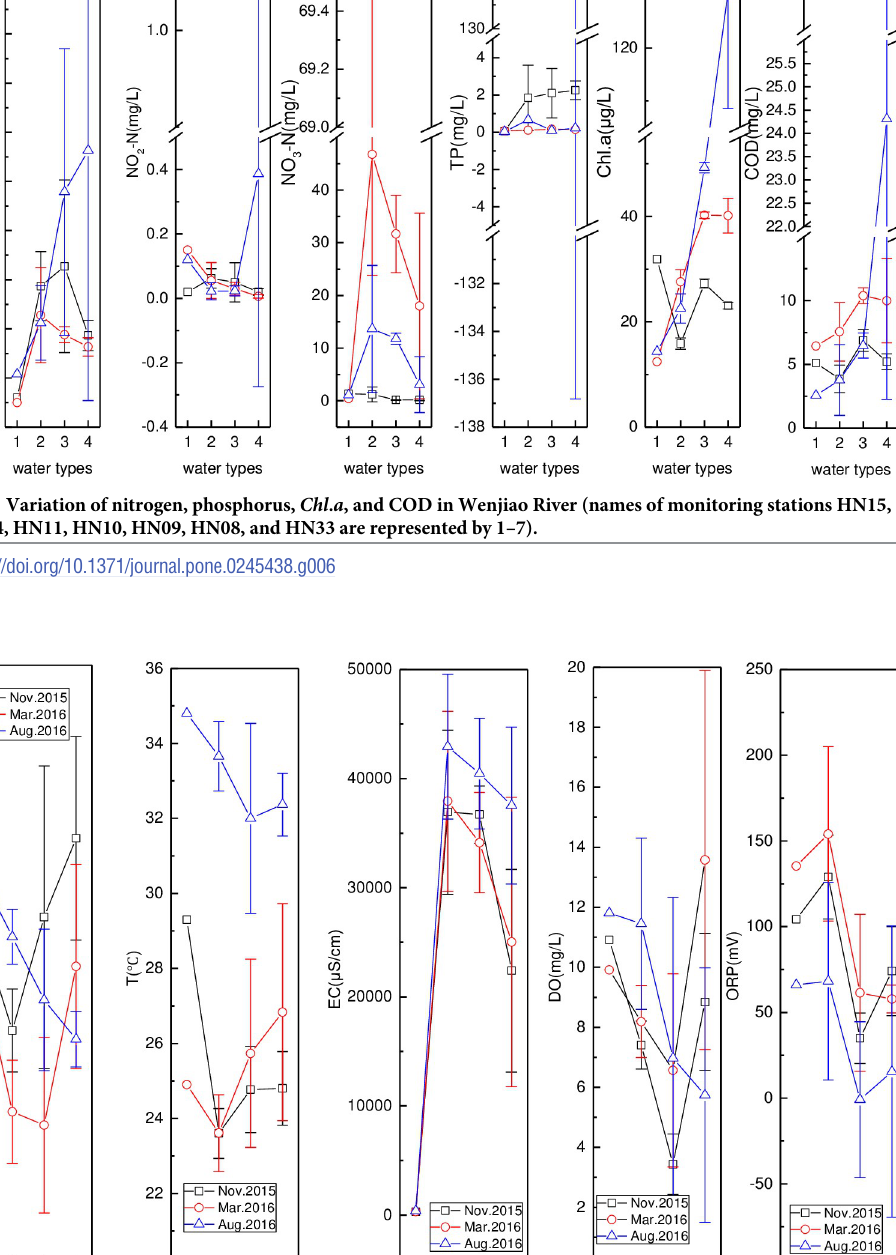
PLOS ONE | https://doi.org/10.1371/journal.pone.0245438 January 22,